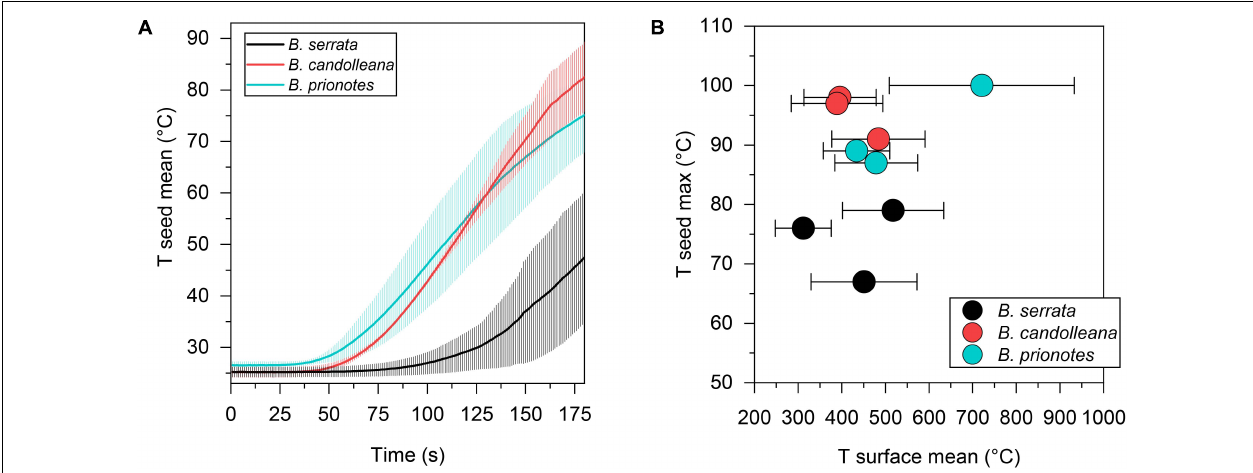
FIGURE 3 | Seed temperatures during the experimental burns. (A) Mean seed temperature ( ± SD, n = 3) for all three species as a function of time, revealing a slow temperature response in B. serrata and a quick response in B. prionotes during burning of follicles for 180 s. (B) Maximum seed temperatures plotted against the mean surface temperature ( ± SD) for each burn shown in Figure 2 . B. serrata shows the lowest maximum seed temperature when compared to the other two species for a similar mean surface temperature.